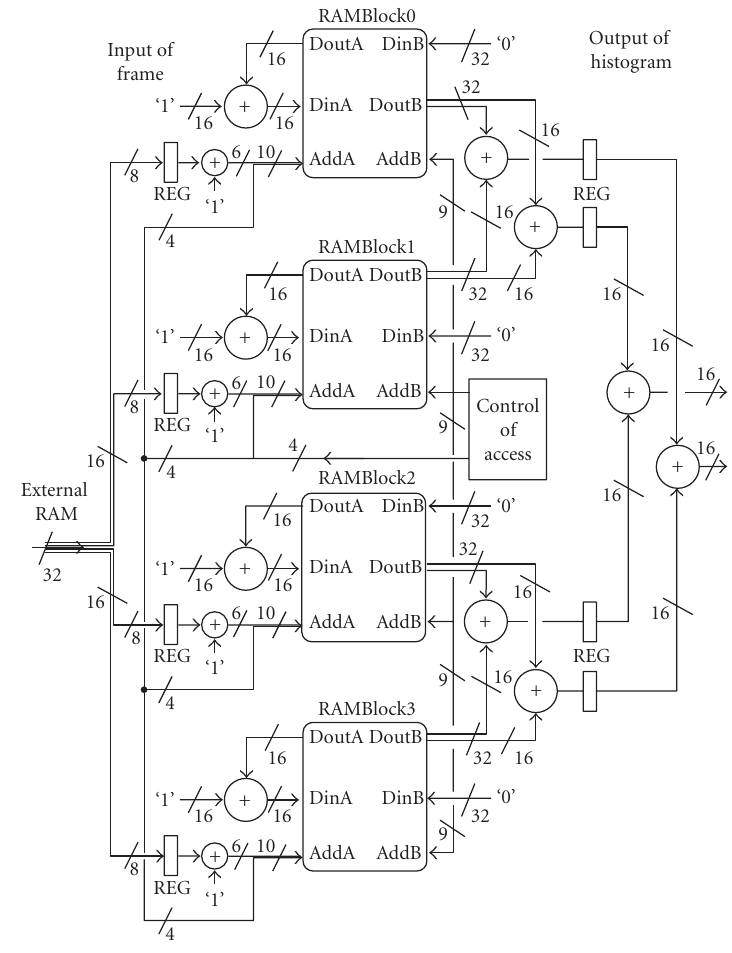
Figure 1: Circuit for calculating the